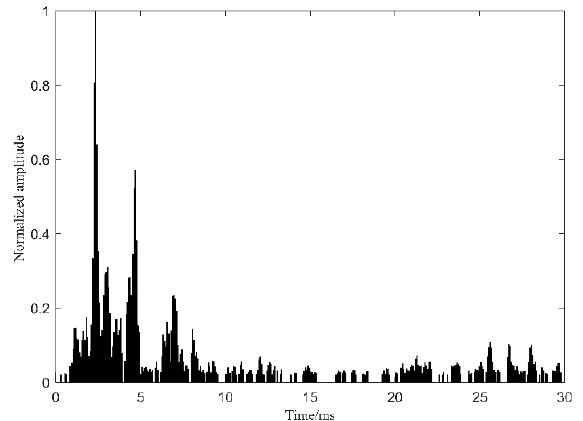
Figure 5. Impulse response of the underwater acoustic channel measured in Qingjiang River at a